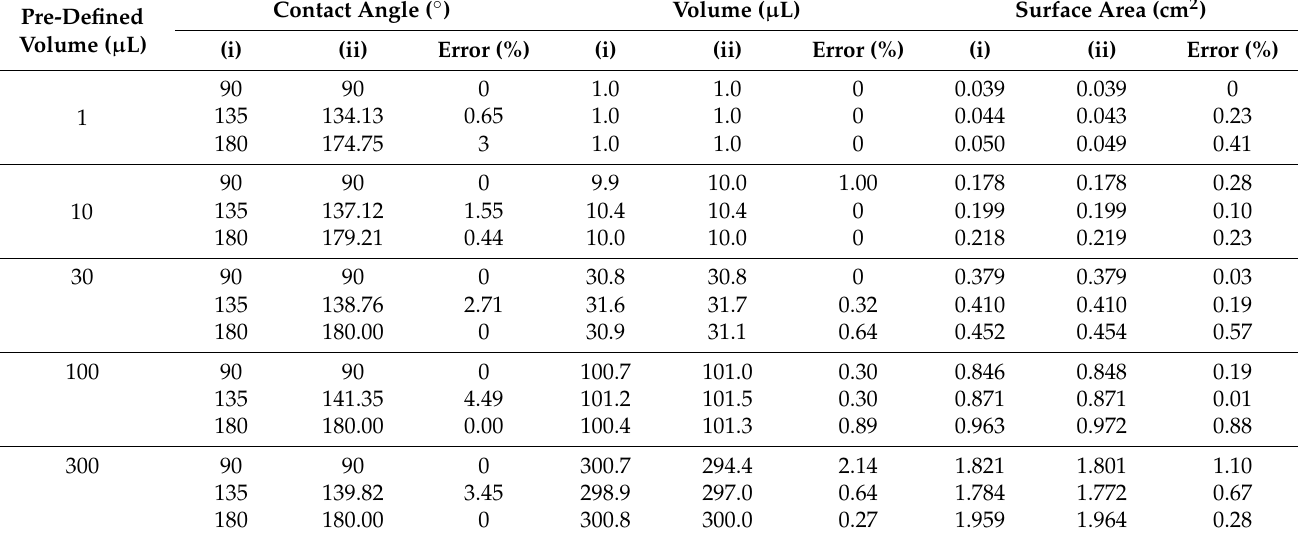
Table 2. Droplet parameters at different volumes and various contact angles: (i) Young–Laplace theoretical droplet; (ii) The Bond numbers of the droplets generated using the Young – Laplace numerical generated droplet using the elliptic method and the elliptic method were also compared (Table 3). The Bond number of each